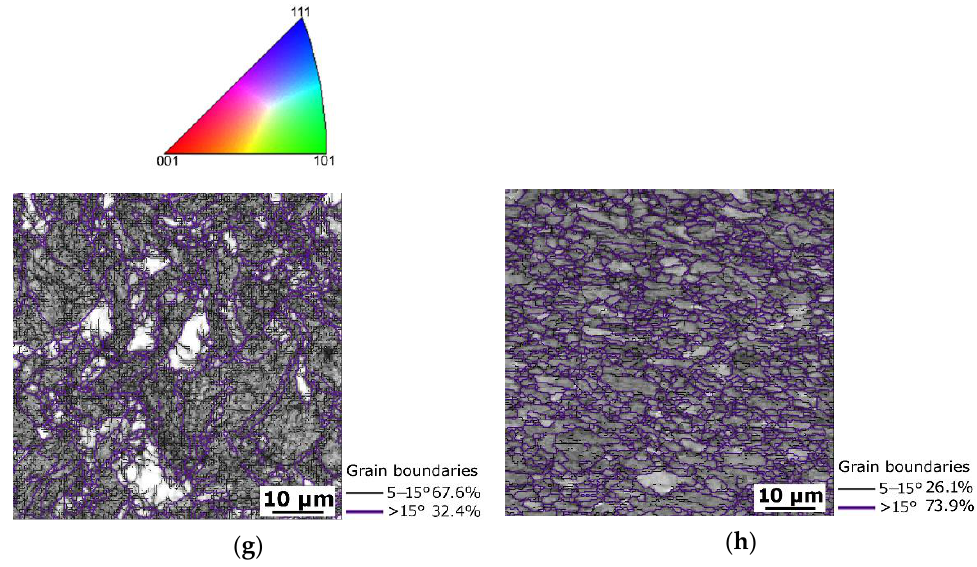
Figure 7. Results of structure analyses for: Cu lamella of 20 mm composite – grain size distribution chart ( a ), orientation image map (OIM) ( b ); Cu lamella of 15 mm composite – grain size distribution chart ( c ), OIM ( d ); Cu lamella of 10 mm composite – grain size distribution chart ( e ), OIM ( f ). Grain boundary analyses for Cu lamella of: 15 mm composite ( g ); 10 mm composite ( h ).